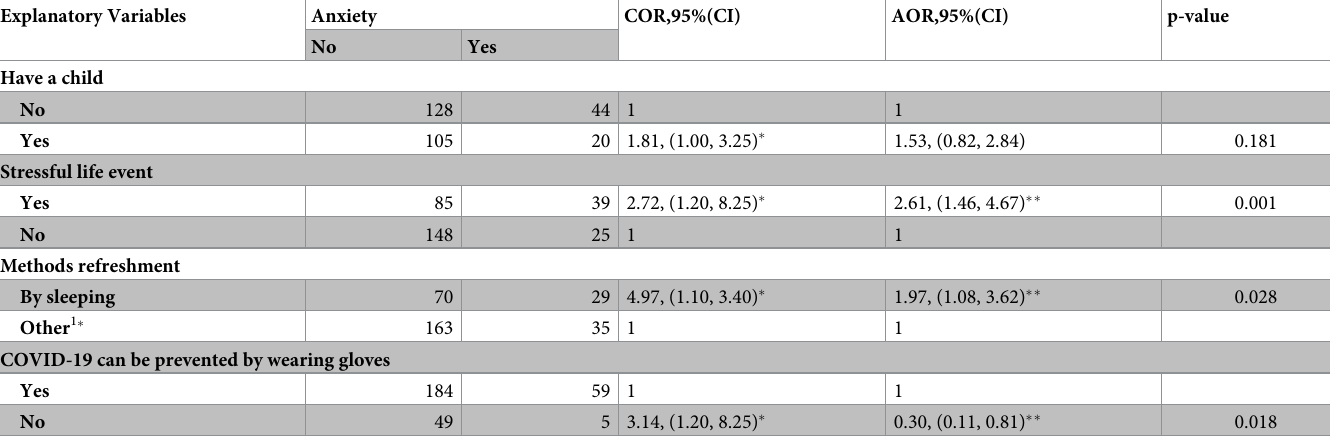
Table 4. Factors associated with anxiety among individuals under Quarantine for the case Covid-19 Pandemic, at Addis Ababa, Ethiopia, 2020. Explanatory